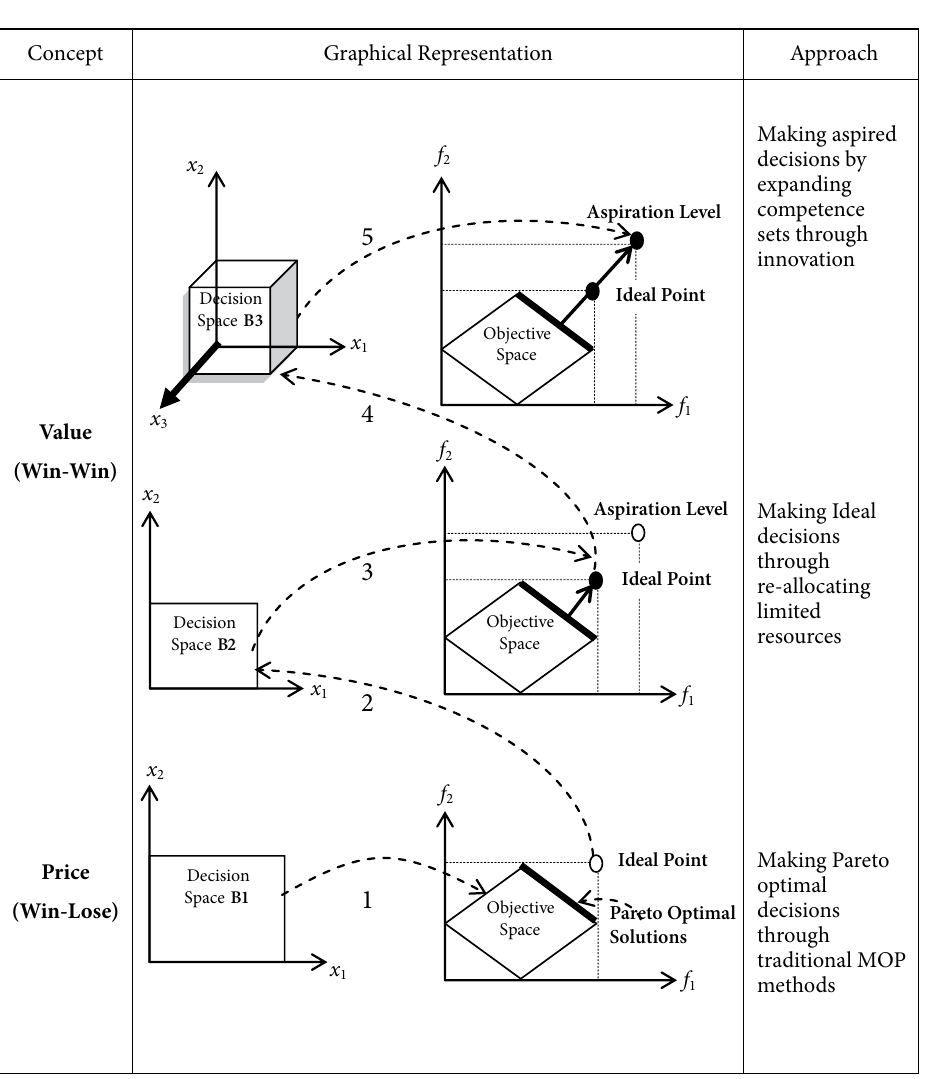
Fig. 1. Basic concept of changeable decision space and aspiration level (Liou, Tzeng